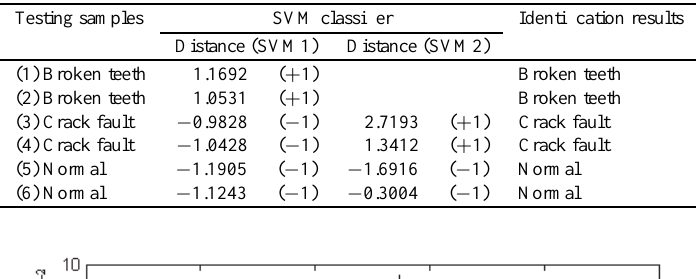
Table 2 The identification results of two SVM classifiers for gear